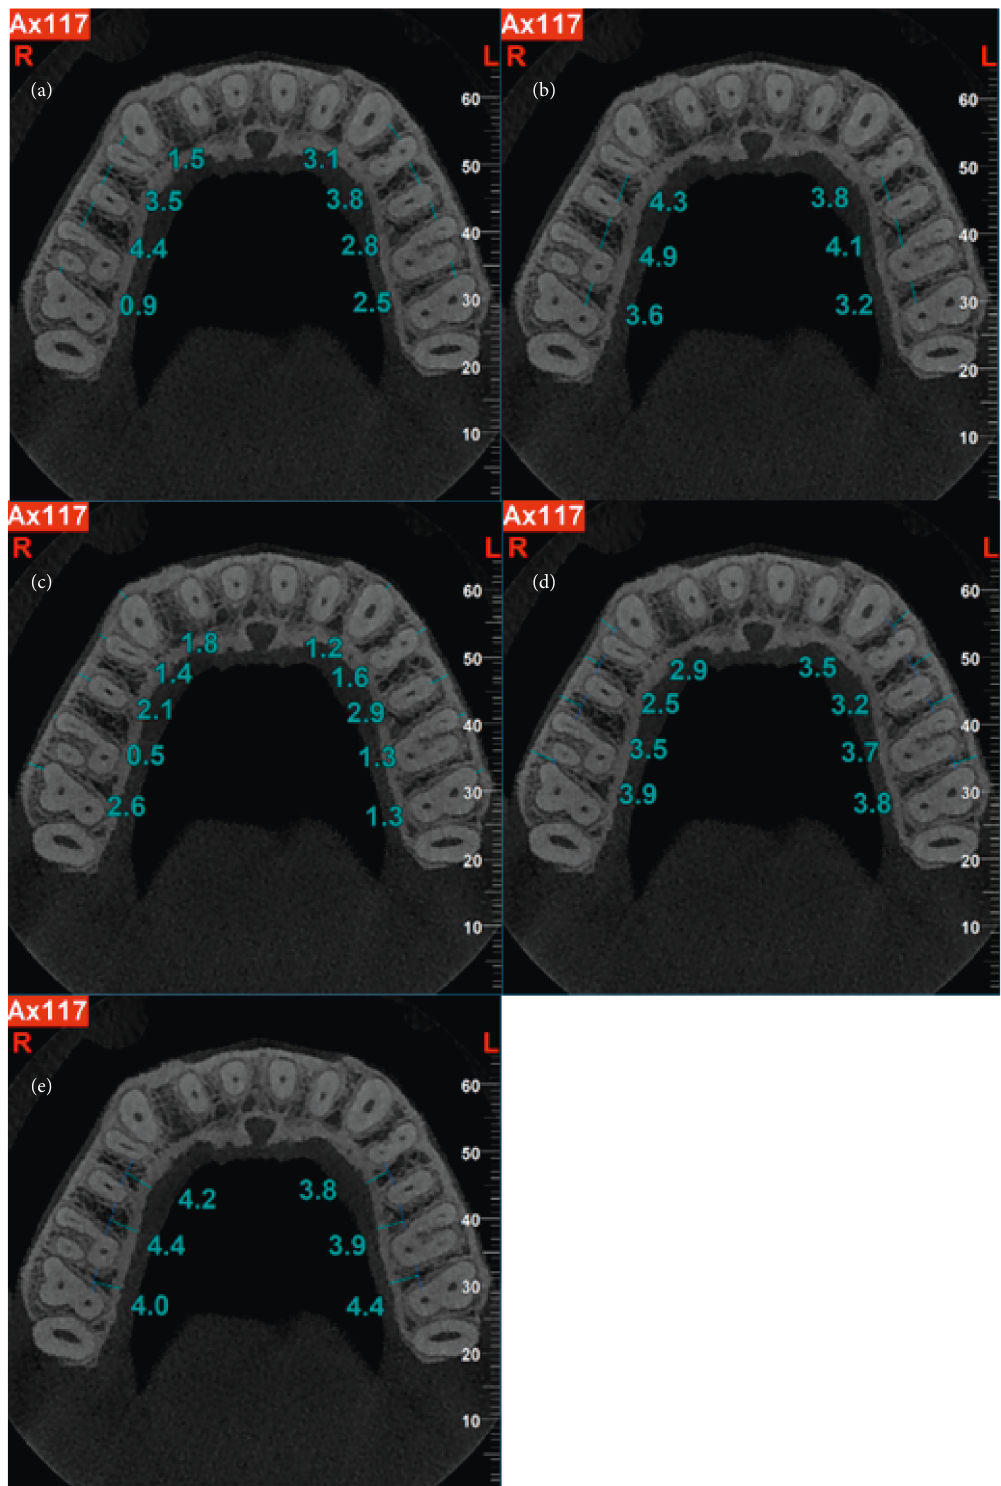
Figure 2: Axial CBCT scans demonstrating measurement (in millimeter) of interradicular distance, cortex thickness, and safe depth of miniscrew insertion. (a) Distance between buccal roots. (b) Distance between palatal roots. (c) Buccal cortex thickness. (d) Safe buccal depth. (e) Safe palatal